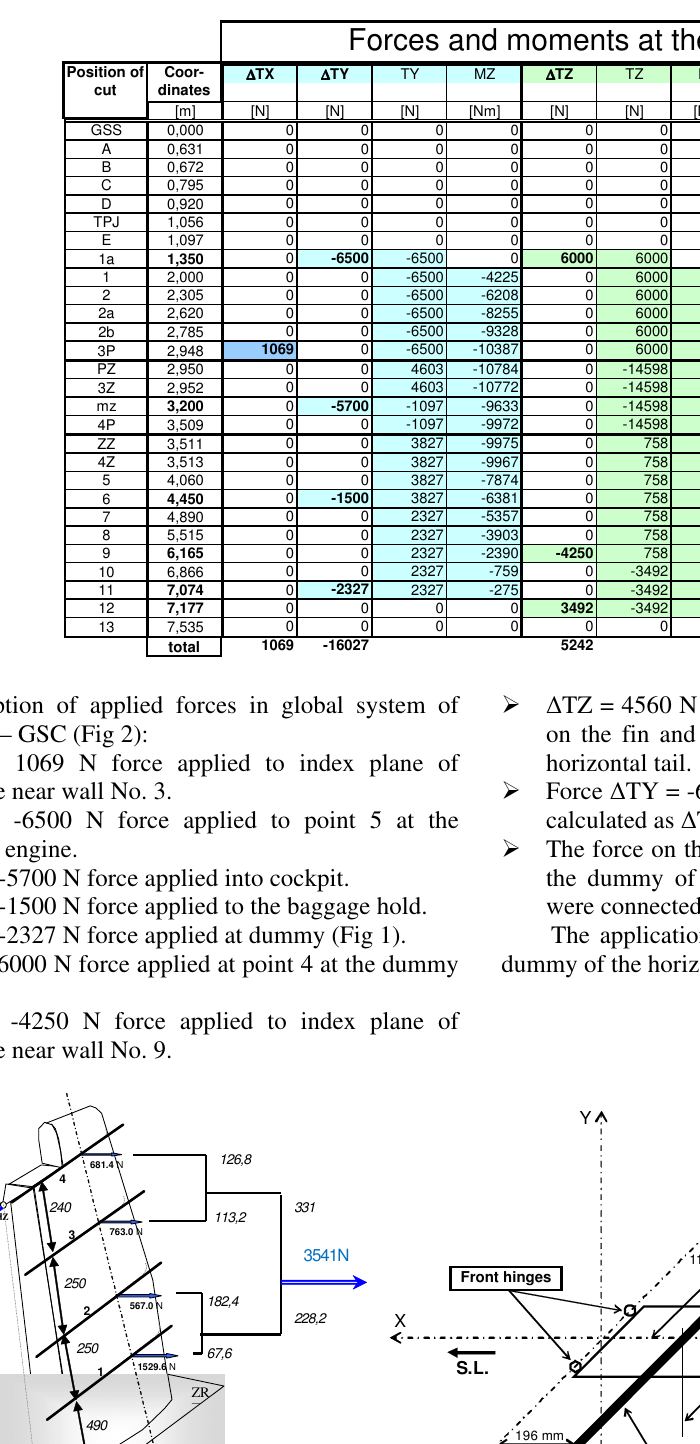
Table 1. Total load forces – case manoeuvre of vertical surfaces